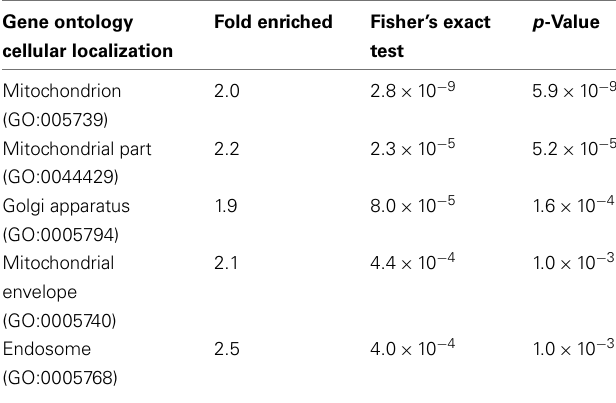
Table 3 | Identification of pathway underlying complex traits using gene